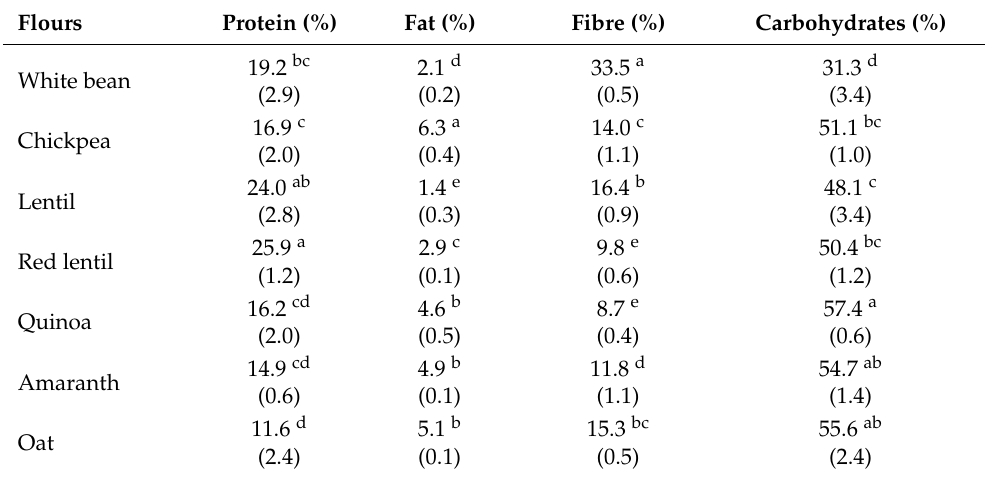
Table 2. Mean values of the proximate composition of flours. Standard deviation in brackets. Flours